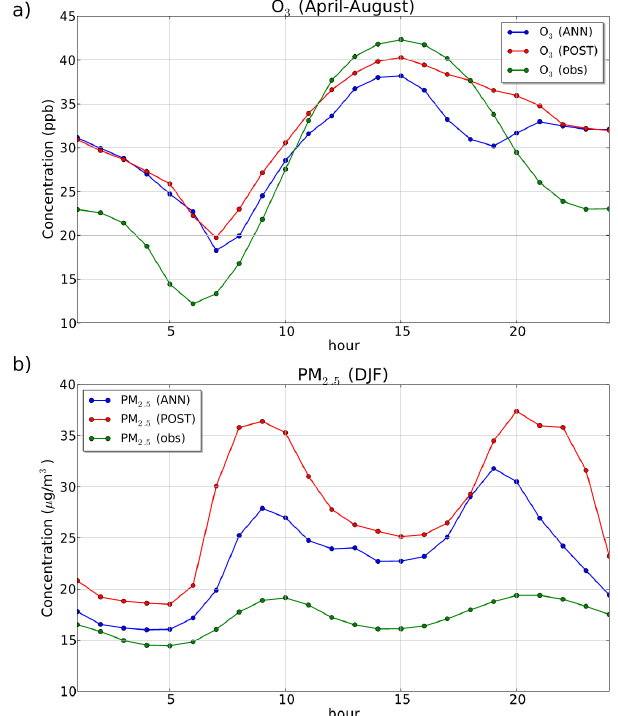
Figure 10. Mean diurnal variation of (a) ozone concentrations aver- aged over the April–August period and (b) wintertime PM 2 . 5 con- centrations in the urban